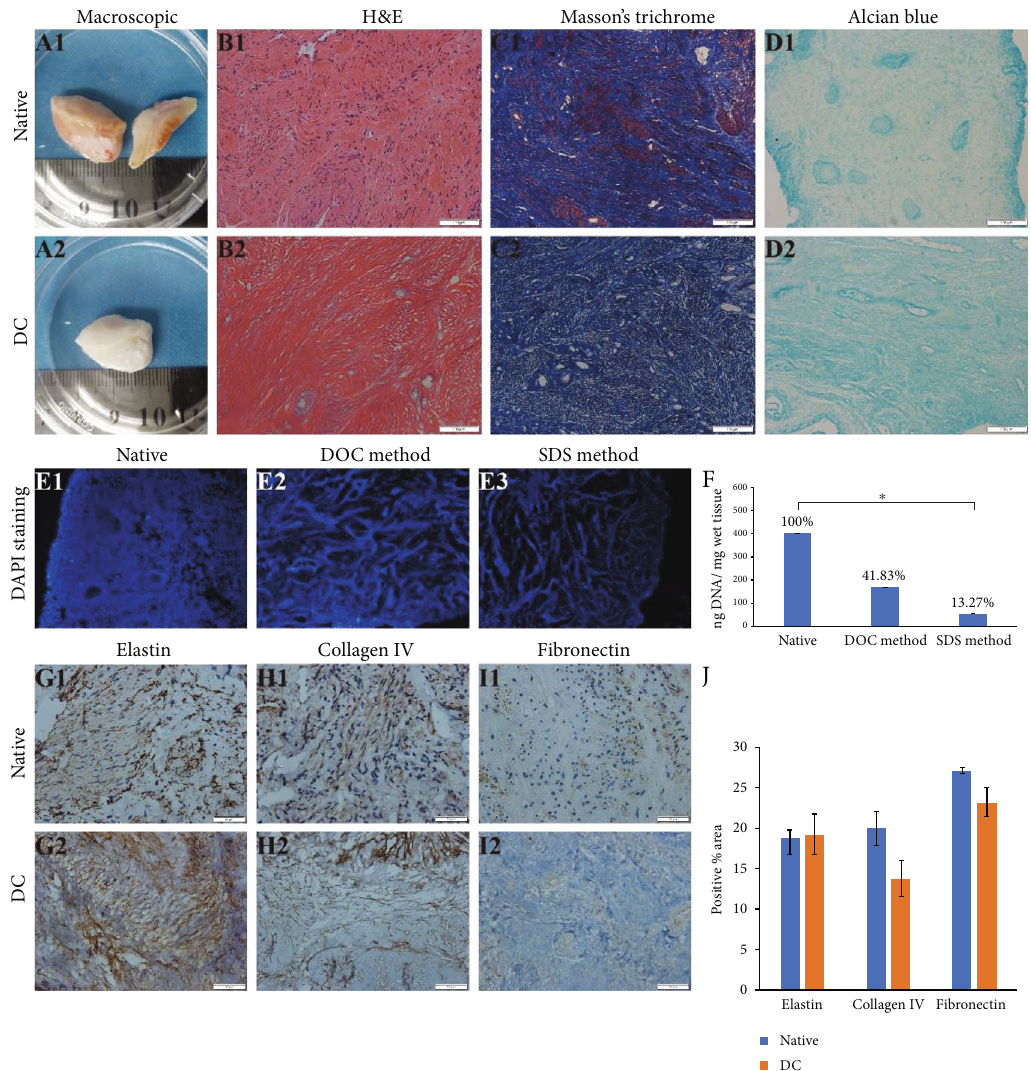
Figure 2: Evaluation of decellularized human cervix. Macroscopic results: the whitening of the tissue was considered as a visual sign of decellularization (a). Representative microscopic images of native human cervical tissue and decellularized sca ff olds from SDS method (b – d). Cellular components were stained by H&E (b). ECM components were stained with Masson ’ s trichrome staining (c) and